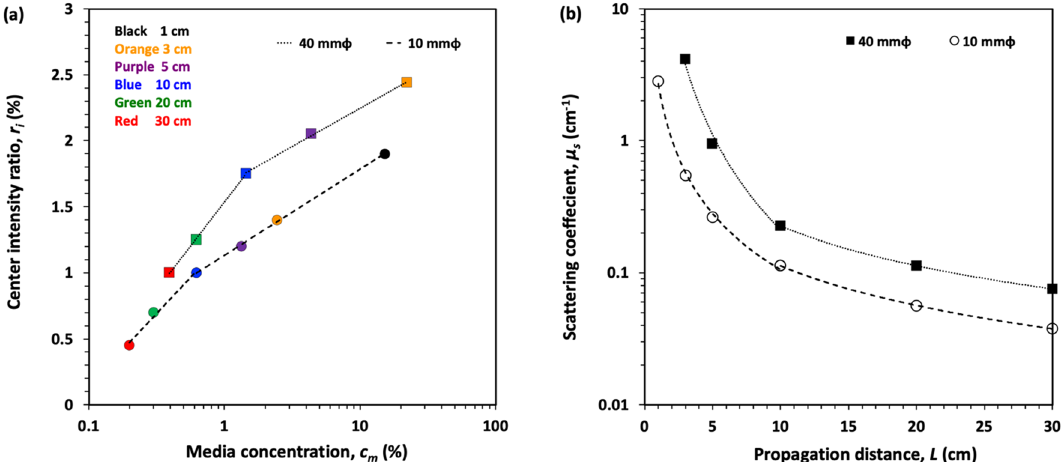
Figure 6. ( a ) Variation of the maximum center intensity ratio ( r i ) with the media concentration, and ( b ) the changes of scattering coefficient with the propagation distance observed from the annular beams with diameters